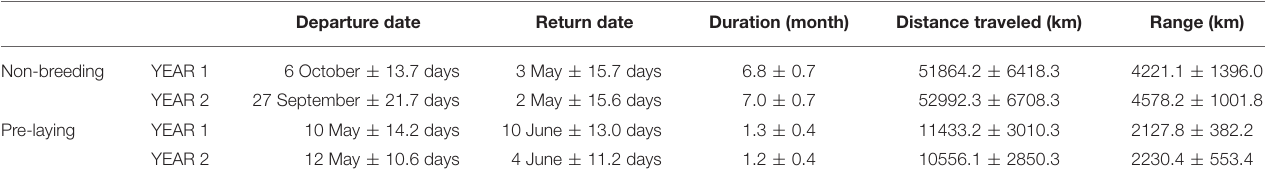
TABLE 1 | Details of the non-breeding and pre-laying at-sea movements performed by sooty terns tracked for 2 years (YEAR1: 2011–2012 and YEAR2: 2012–2013) from Bird Island, Seychelles, Indian Ocean.